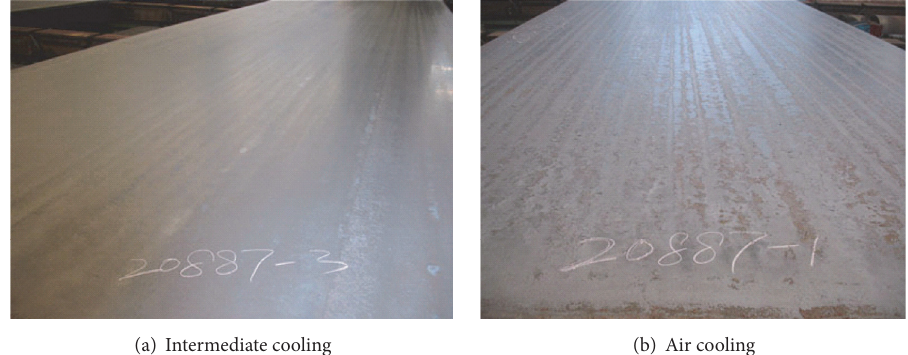
Figure 9: Comparison of surface qualities of steel plates under different cooling